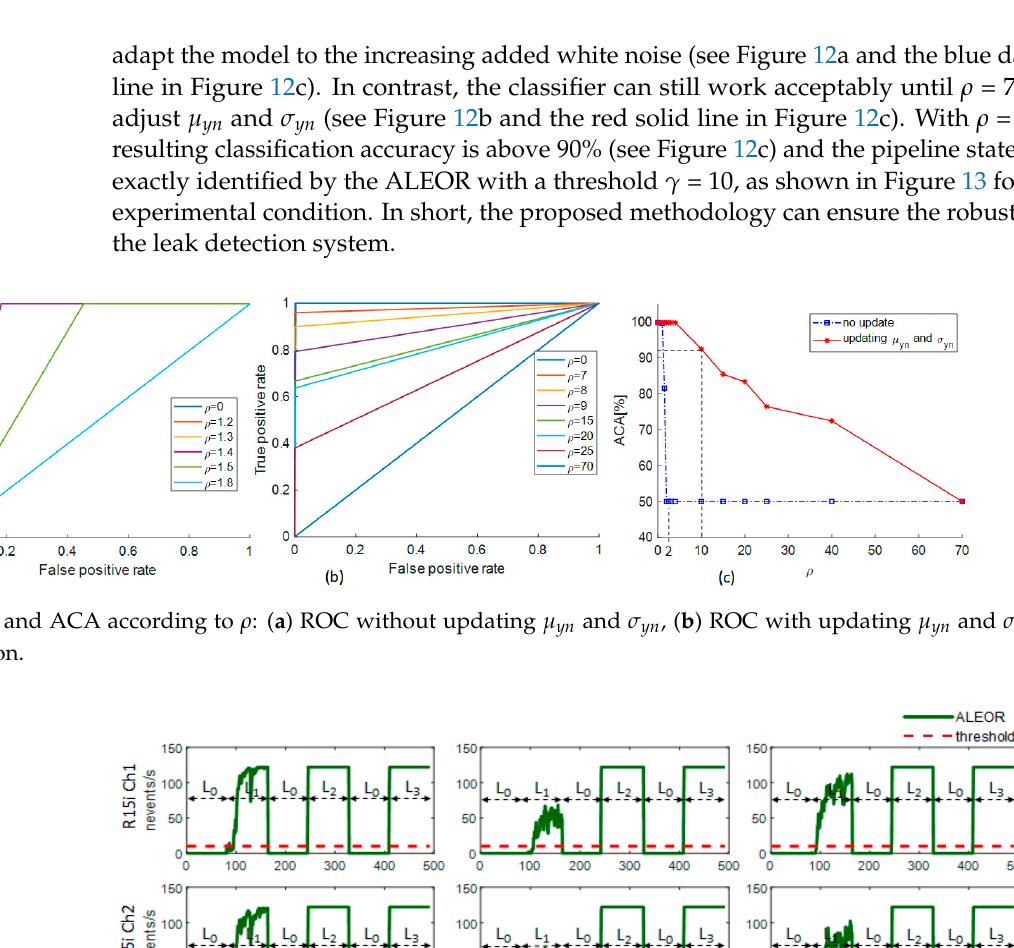
Figure 11. A signal after adding a white noise with ρ = 2.